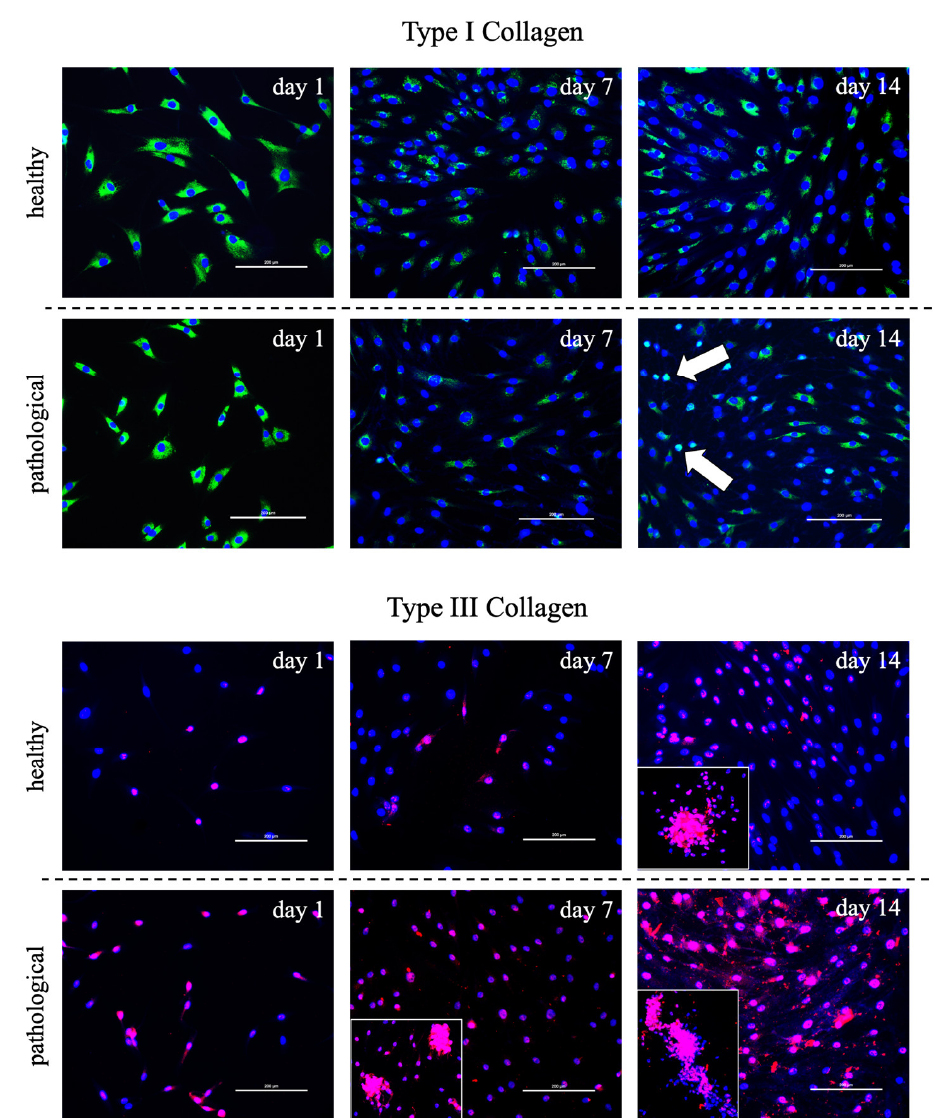
Figure 6. Immunofluorescence images of healthy and pathological tissue-derived tendon stem/progenitor cells (TSPCs) cultured in a medium supplemented with T3 (10 −6 M) up to 14 days. Type I (green) and III (red) collagen expression was monitored. DAPI was used to counterstain the nuclei (blue). Pathological cells exhibited an ovoid morphology (white arrow) and tended to form aggregates with enhanced type III collagen secretion (zoomed area: 150%). Scale bar: 200 μm.